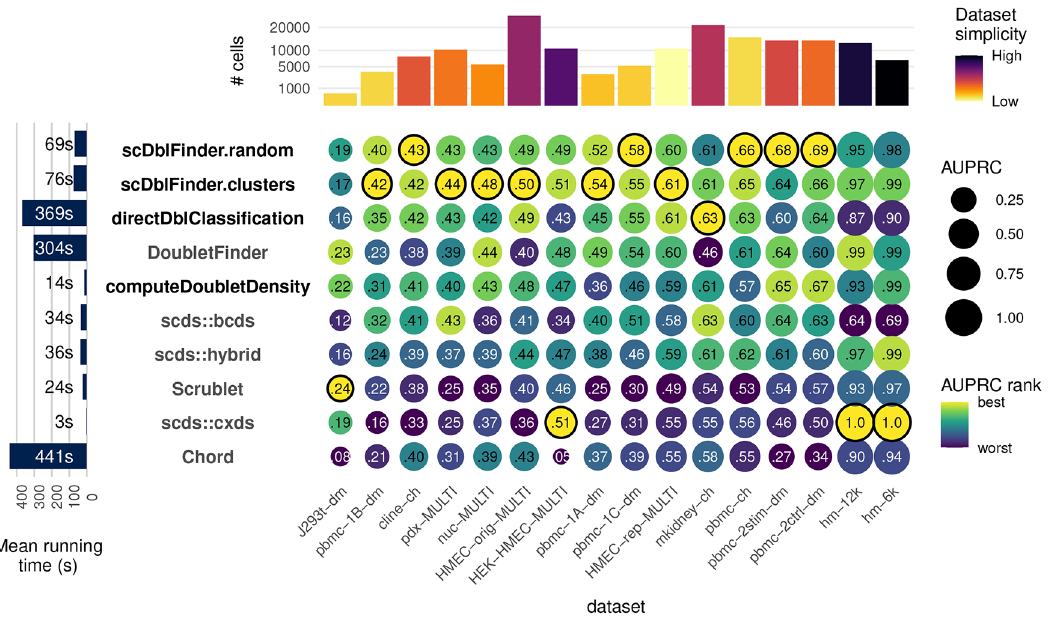
Figure3.Benchmark. Accuracy(areaundertheprecisionandrecallcurve)ofdoubletidentificationusingalternative methods across 16 benchmark datasets. The colour of the dots indicates the relative ranking for the dataset,